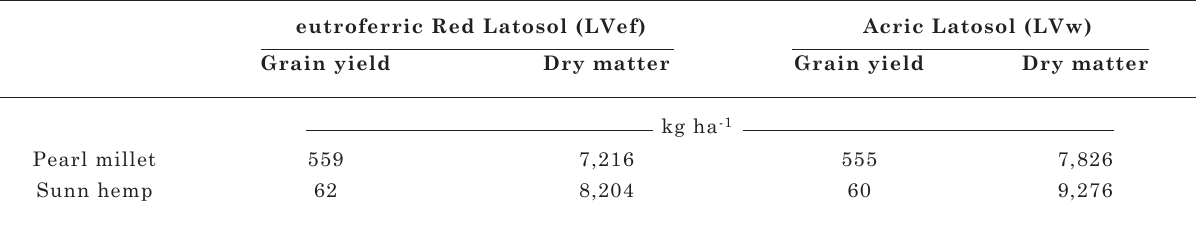
table 3. grain yield and residue dry matter after pearl millet and sunn hemp